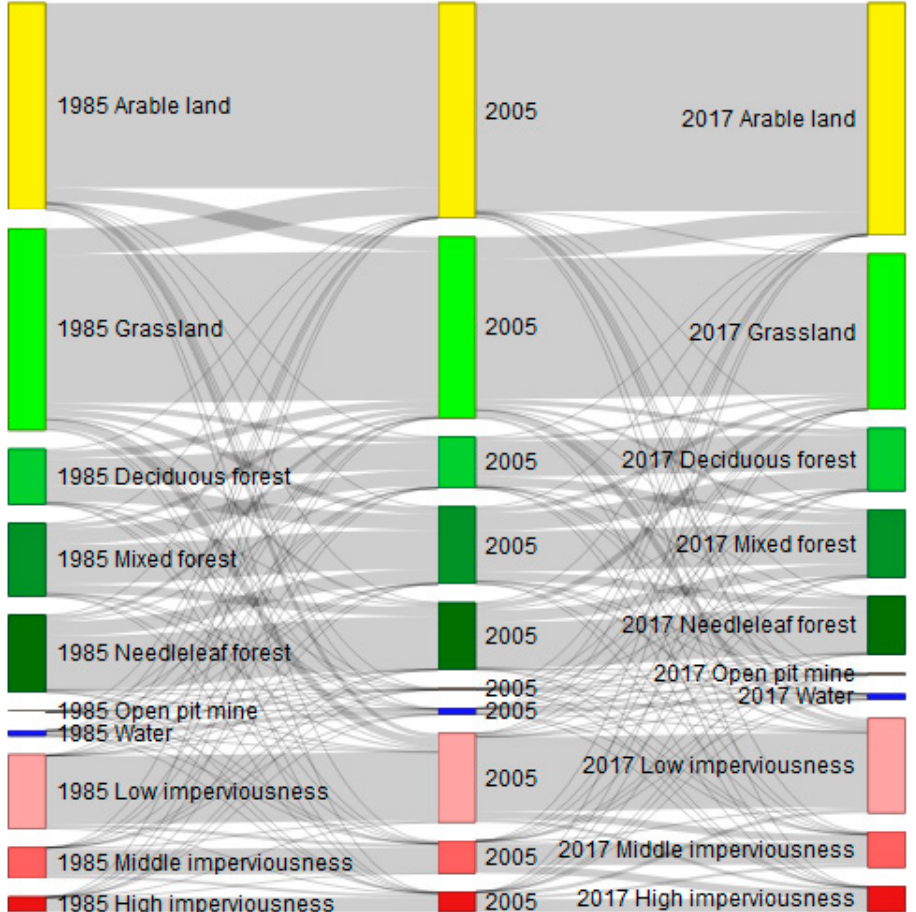
Figure 4. Sankey plot for land-use changes observed in NRW from 1985 to 2017.